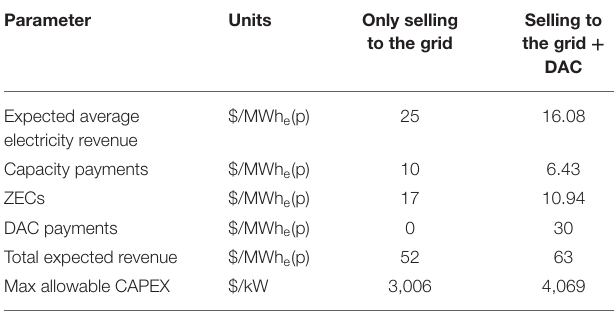
TABLE 5 | Potential revenue streams for allowed CAPEX.